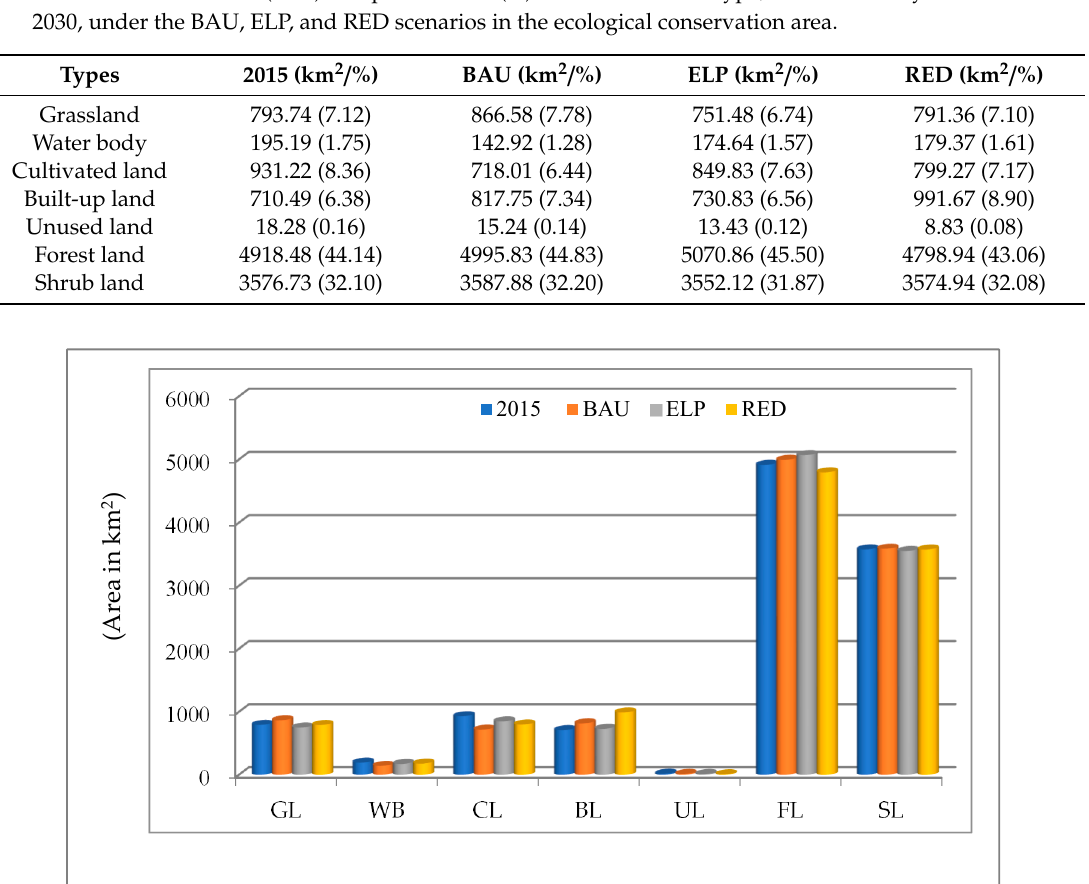
Table 3. Land-use conversion matrix from baseline year 2015 to 2030, under the BAU, RED, and ELP scenarios in the ecological conservation area (km 2 ). Scenarios